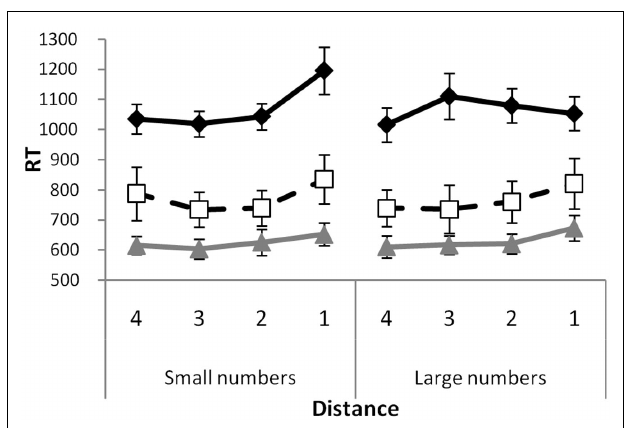
FIGURE 3 | Distance effects for small and large numbers separately in neglect patients, patients without neglect and healthy controls. The data points reflect mean reaction times and the error bars give the SEM across